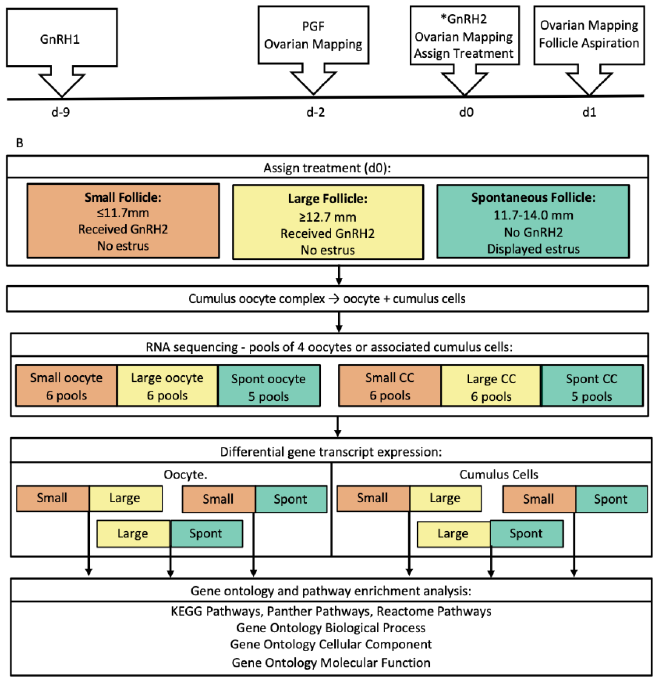
Figure 1. ( A ) Protocol for synchronization of ovulation and determination of follicle diameter by ultrasonography. The cumulus oocyte complex was collected by transvaginal aspiration on d 1. * Cows assigned to the Spontaneous (Spont) follicle classification did not receive GnRH2 injection on day 0. ( B ) Cows that did not express estrus by d 0 were assigned to the Small (≤11.7 mm) or Large Follicle (≥12.7 mm) groups based on largest follicle diameter on d 0. Cows that expressed estrus by d 0 were assigned to the Spont Follicle group regardless of ovulatory follicle size. Pools of four oocytes or associated cumulus cells were prepared for generation of RNA sequencing data and analyses. Differential gene transcript expression for both oocyte and cumulus cell pools was analyzed as follows: Small vs. Large, Small vs. Spont, and Large vs. Spont. Gene ontology and pathway enrichment was analyzed as shown in the